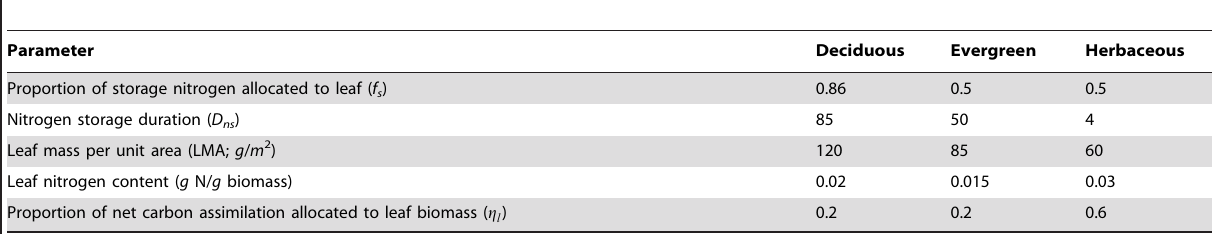
Table 3. Model parameters of deciduous, evergreen trees and herbaceous plants for the sensitivity analysis.